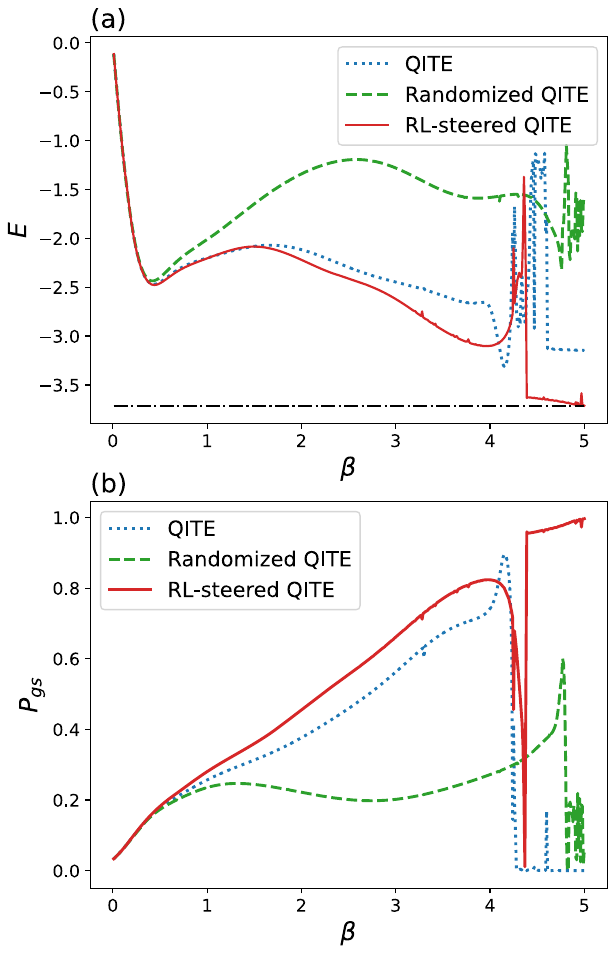
Fig. 4 Different QITE schemes for the Sherrington – Kirkpatrick model. Blue dotted lines represent the standard quantum imaginary time evolution (QITE); green dashed lines represent the randomized QITE; red lines represent the reinforcement learning (RL)-steered QITE. a Energy versus the imaginary time β . The black dash-dotted line represents the ground state energy. b Success probability versus the imaginary time β